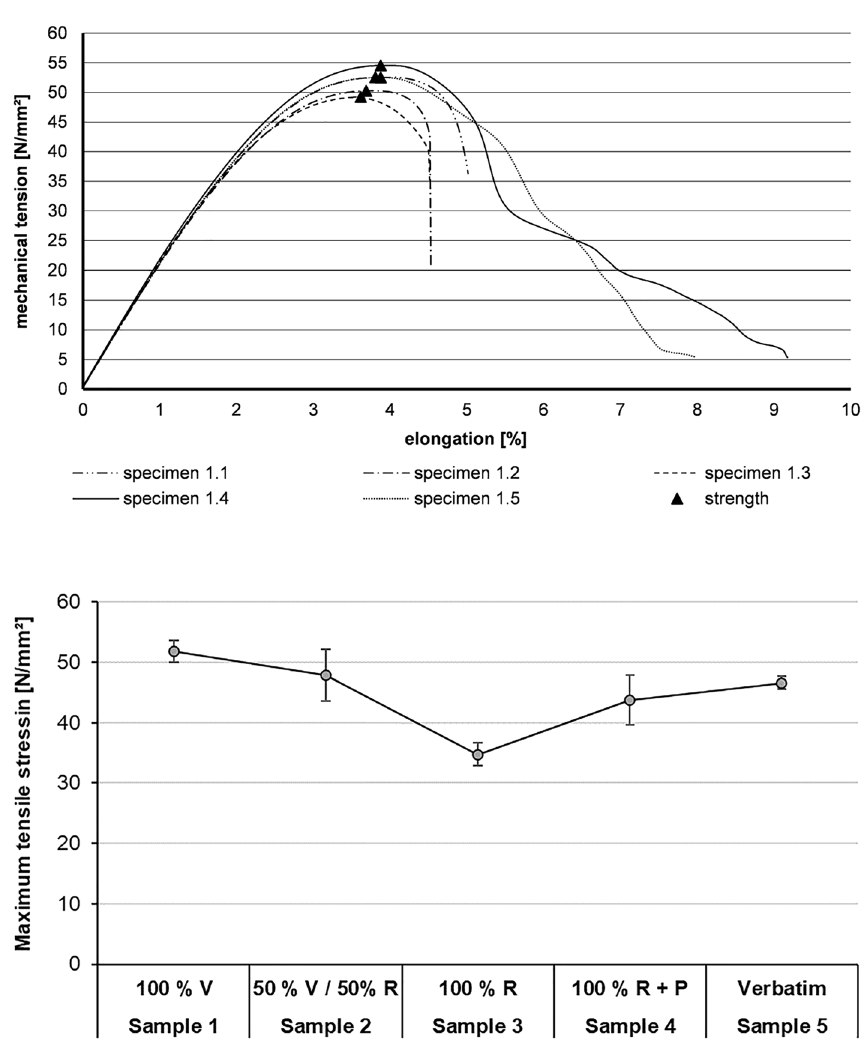
Fig. 9 Stress–strain diagram sample 1 (100% virgin mate- rial)